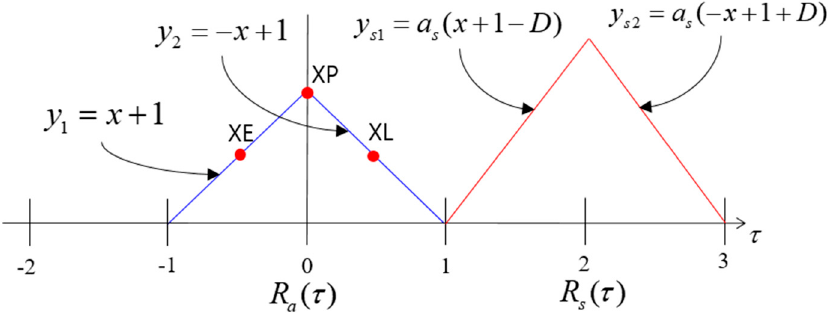
Figure 2. ACFs of the authentic and spoofing signal models.